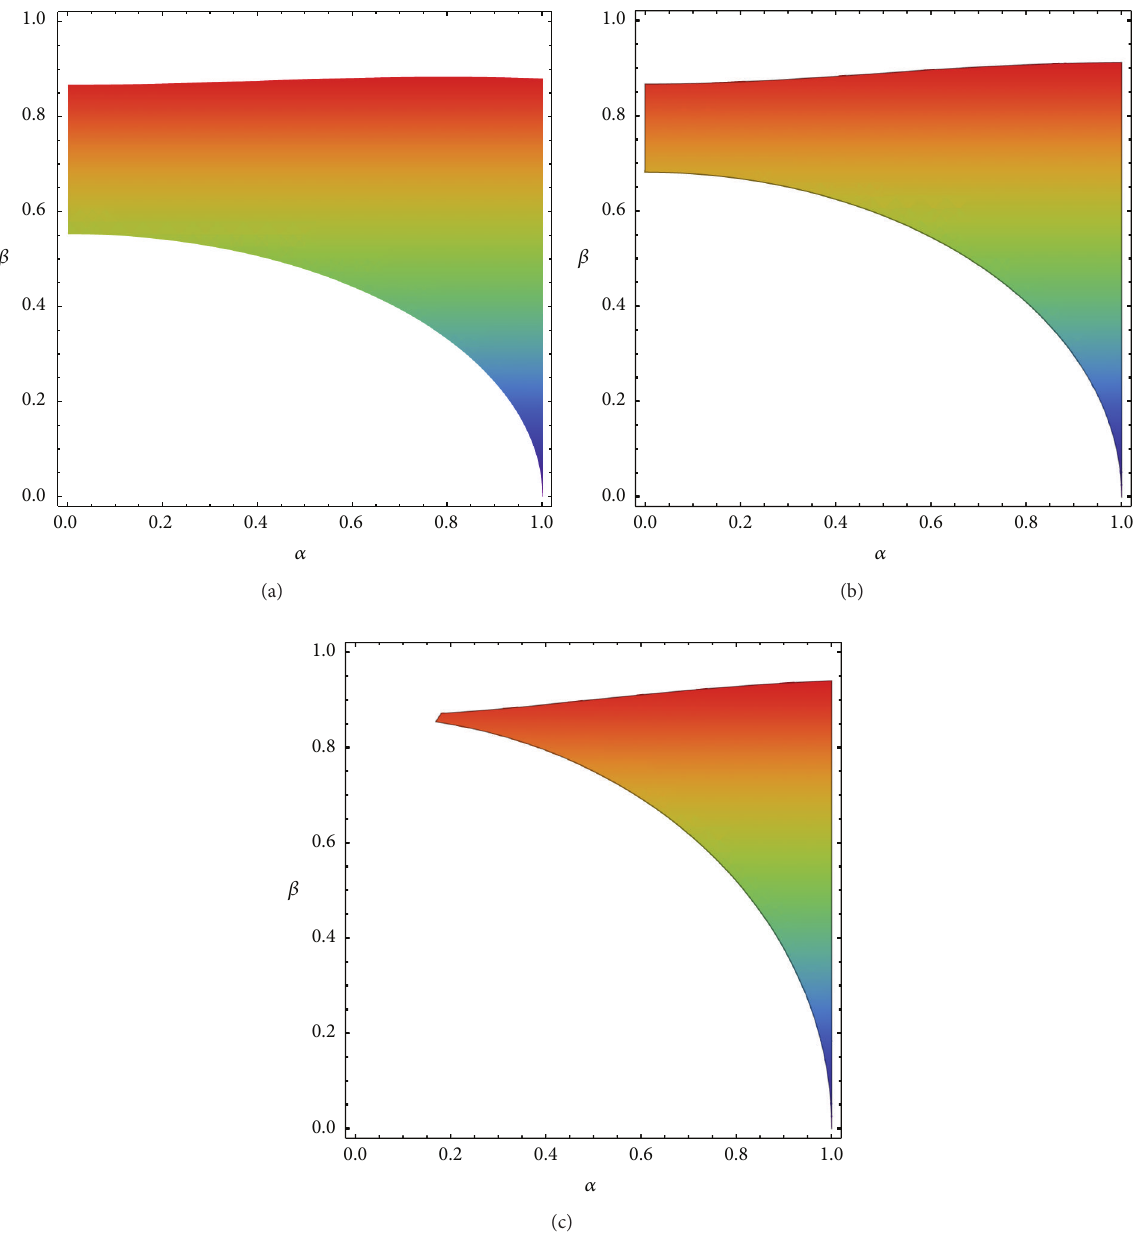
Figure 6: Cross sections of the central configurations region in the general case when 𝑀, 𝑚 0 > 0 and (a) 𝐶 = 0.1 , (b) 𝐶 = 0.3 , and (c) 𝐶 = 0.5